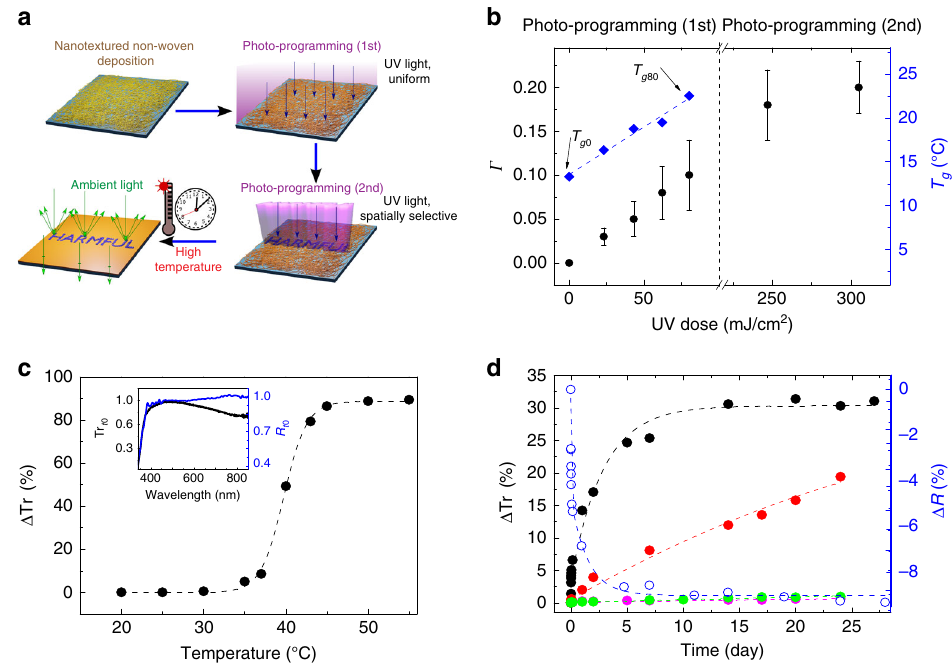
Fig. 1 Photo-programming of thermal properties. a Schematic representation of the indicator photo-programming. SU-8 fi brous non-woven deposition and photo-programming (blue vertical rays) at calibrated optical dose and pattern activation. A warning sign will appear when the subsequently experienced time – temperature pro fi le overcomes targeted programmed values (i.e., correct item storage conditions) by diffuse re fl ectance contrast (green rays). b Calculated average values of the cross-linking degree, Γ , at different exposure doses during photo-programming (left vertical scale). Data are averaged over at least three samples for each dose (error bars: SD). DSC in fl ection points ( T g , right vertical scale) for the non-woven fabrics following the fi rst step of photo-programming at different UV doses are also displayed. The blue line is a linear fi t to the experimental data (diamonds). T refer to samples photo-programmed (step 1) with UV doses: 0 and 80 mJ/cm 2 , respectively. c Optical transmission change (dots, Δ Tr) at λ = 510 nm, vs. temperature, for a fabric with fi rst step of photo-programming at 80 mJ/cm 2 . The dashed line is a guide for the eye. Inset: Normalized Tr t 0 (black line, left vertical scale) and R t 0 (blue line, right vertical scale) spectra. Tr t 0 and R t 0 are the optical transmission and the diffuse re fl ectance measured at t 0 = 0, respectively. R t 0 was measured by means of an integrating sphere (see Methods). d Temporal variation of Δ Tr (at λ = 510 nm, left vertical scale) for samples kept at T amb (~ 20 °C, pink dots), 25 °C (green dots), 30 °C (red dots) and 35 °C (black dots). The corresponding optical re fl ectance change, Δ R (at 510 nm, empty dots, right scale), vs. time is also shown for samples at 35 °C. Dashed lines are guides for the